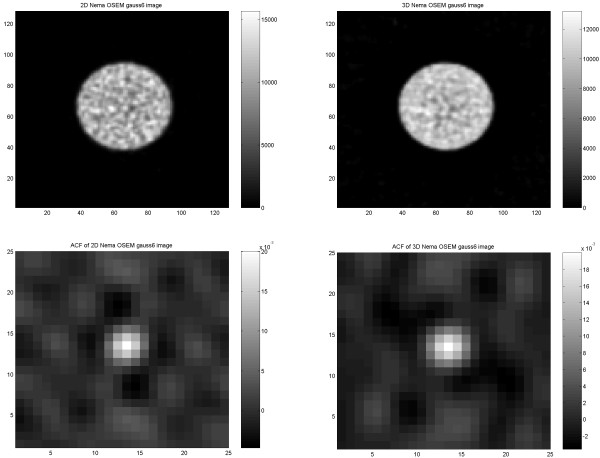
Results of the cylindrical NEMA phantom study. 2D image (upper left) and 3D image (upper right) reconstructed using OSEM with applied 6 mm (FWHM) Gaussian filter. Corresponding ACF images of 2D (lower left) and 3D image (lower right).